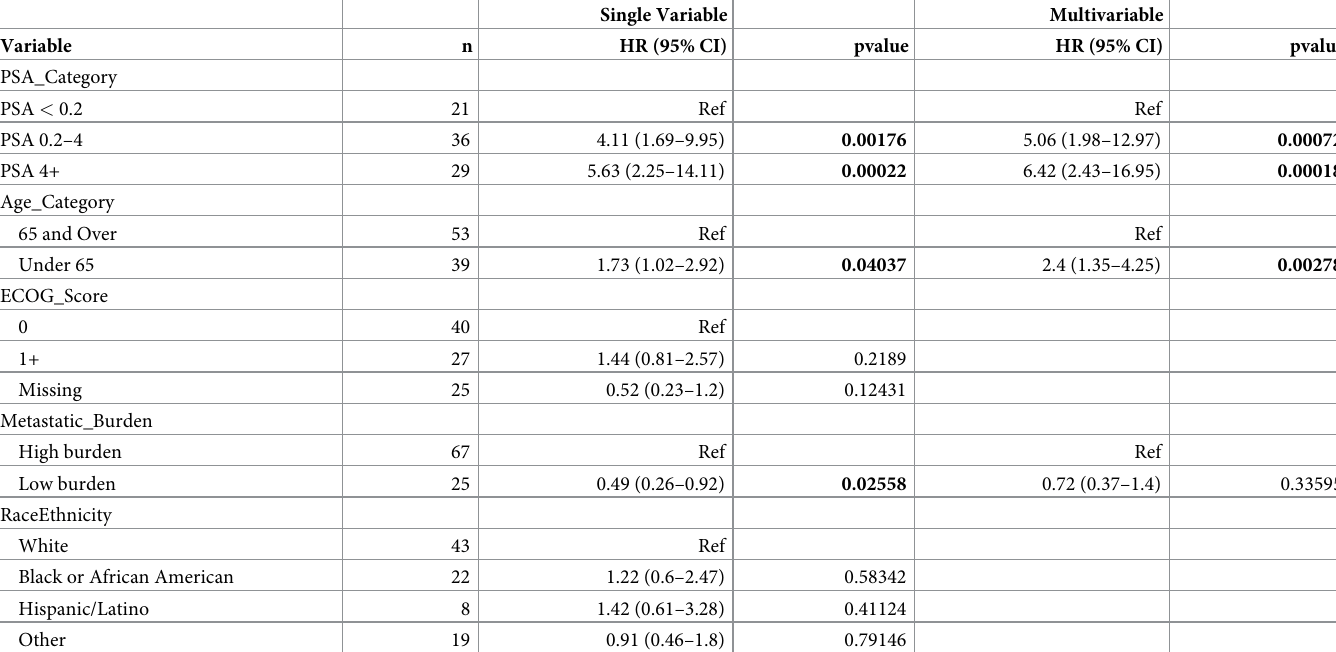
Table 3. Univariable and multivariable analysis of TTNT in mHSPC patients stratified by post treatment PSA and other